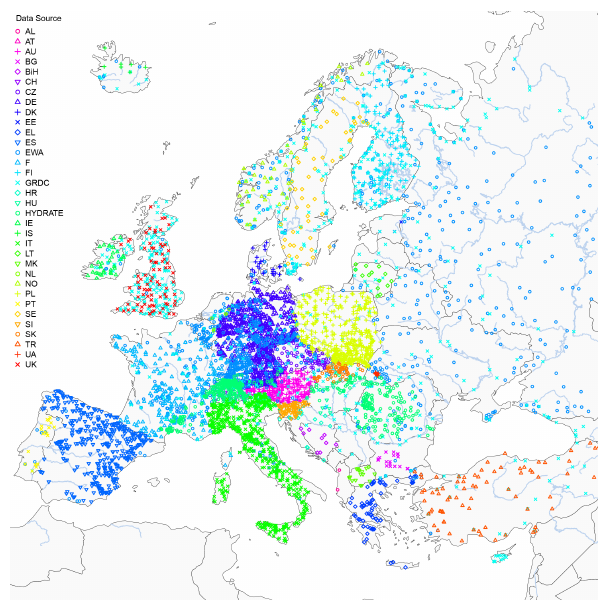
Figure 1. European Flood Database composed of different national and international data sources. Within the same country different regional data sources are shown under the same combined national label.